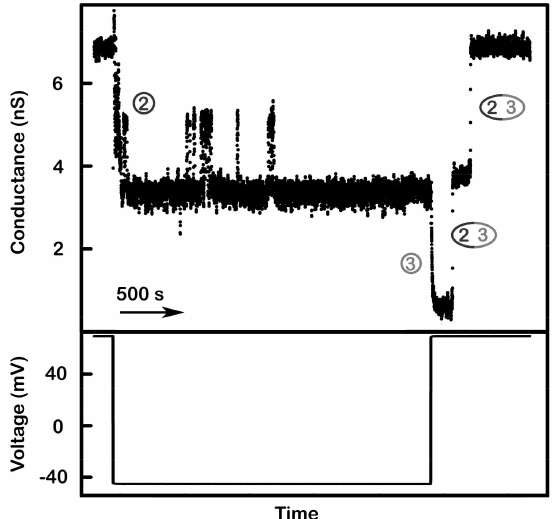
Figure 8. The virtually simultaneous reopening of channel 2 and 3 demonstrates strong cooperative behavior. A single triplin was probed with a 71 mHz (13.6 mV / s) triangular voltage ramp. ( A ) A portion of the recording is shown whereby three successive voltage ramps show essentially simultaneous reopening of channels 2 and 3. ( B ) A conductance vs. voltage plot of the data in the shaded area in (A) was generated and annotated to indicate which channels are gating. Both (A) and (B) show channel 2 closure at a negative voltage, then channel 3 closing as the potential became positive, followed by simultaneous reopening of channels 2 and 3. ( C ) Expanded view of the circled area in (A) showing that the current increased within 5 ms.